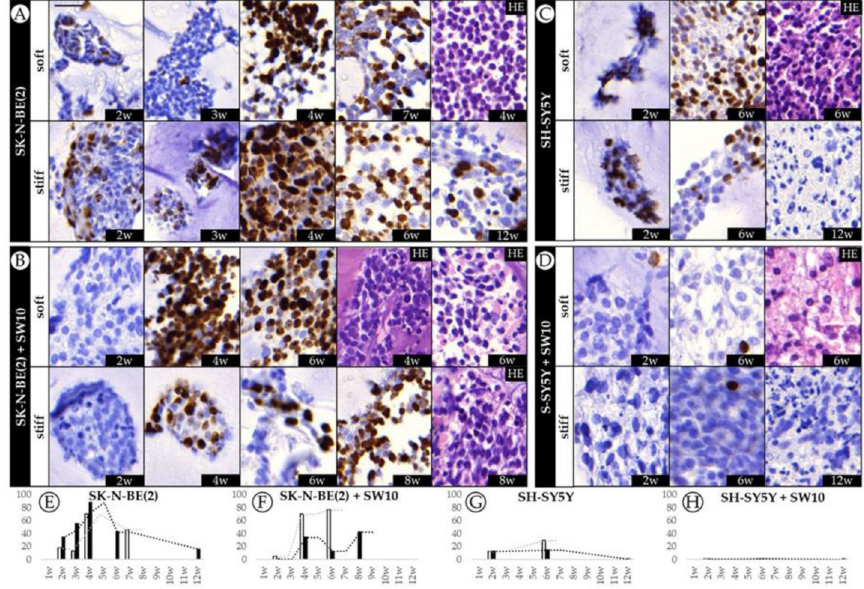
Figure 2. Dynamics of SK-N-BE(2) cell and SH-SY5Y cell proliferative indices over time. ( A – D ) Representative images of Ki67 expression at the time points studied (w: weeks) and hematoxylin eosin (HE) for each cell culture / co-culture in soft and sti ff sca ff oldings. The images on the left correspond to the SK-N-BE(2) cell line cultivated ( A ) alone and ( B ) with mouse Schwann cell line (SW10); the images on the right represent the SH-SY5Y cell line cultivated ( C ) alone and ( D ) with SW10 cells. Scale bar 25 µ m at top left of the first image. Same scale bar is valid for all images. ( E – H ) Bar chart quantification of Ki67 staining (% of positive cells) for ( E ) SK-N-BE(2) cells and ( F ) SK-N-BE(2) cells plus SW10 cells in soft and sti ff sca ff olds, and for ( G ) SH-SY5Y cells and ( H ) S-SY5Y cells plus SW10 cells in soft and sti ff sca ff olds. White and black bars: soft and sti ff sca ff olds, respectively. Dashed lines indicate moving average per sti ff ness condition. X axis: time in weeks (w) and Y axis: % of Ki67 positive